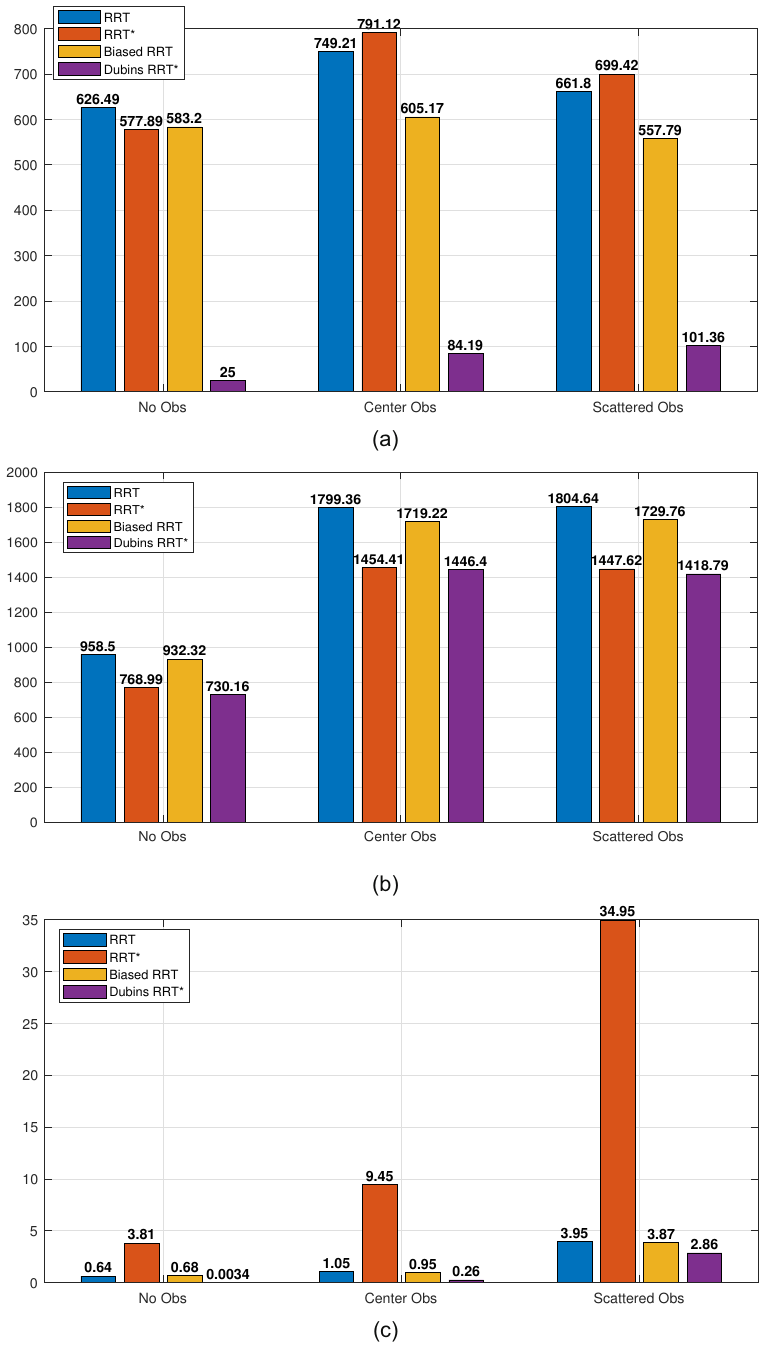
Figure 12. Results of 100 simulations: ( a ) Total number of nodes. ( b ) Path length. ( c ) Calculation